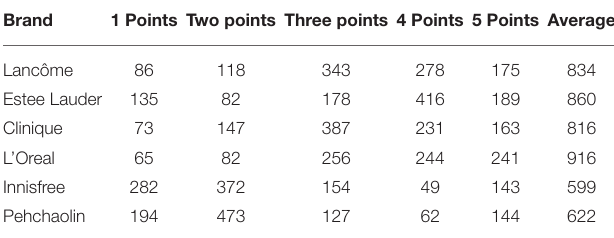
TABLE 4 | The questionnaire scoring details of different brands.